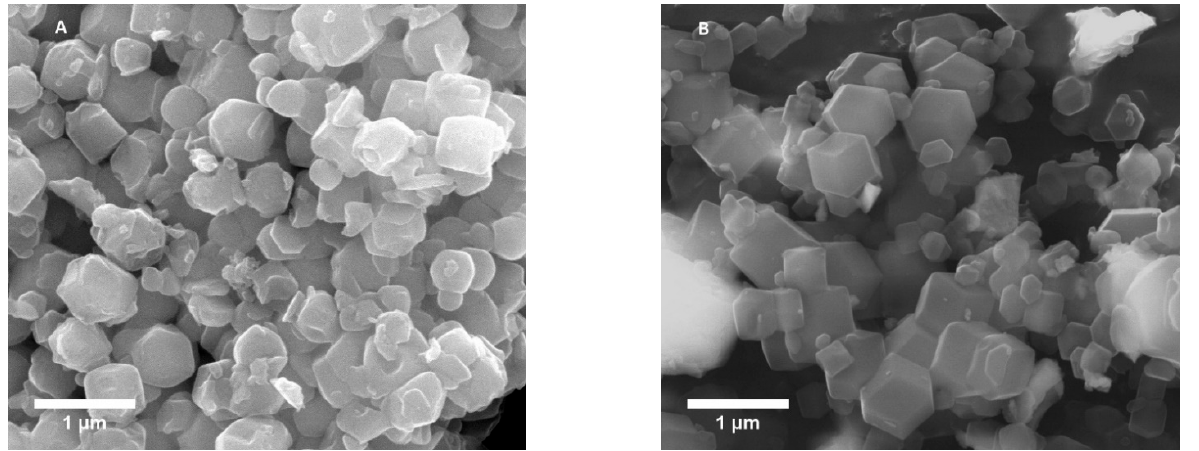
Figure 3. SEM images of ( A ) ZIF-8 support and ( B ) EuW 10 @ZIF-8 composite material.